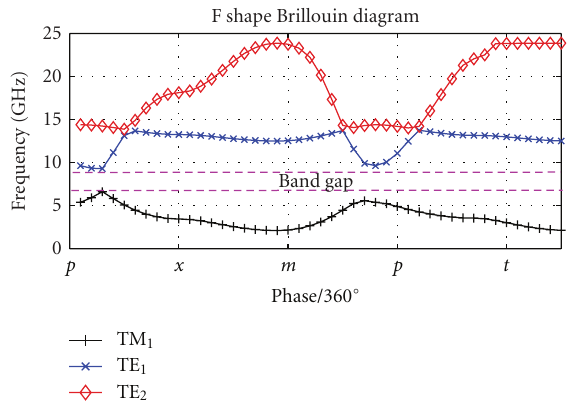
Figure 6: Brillouin diagram for F shape mushrooms.